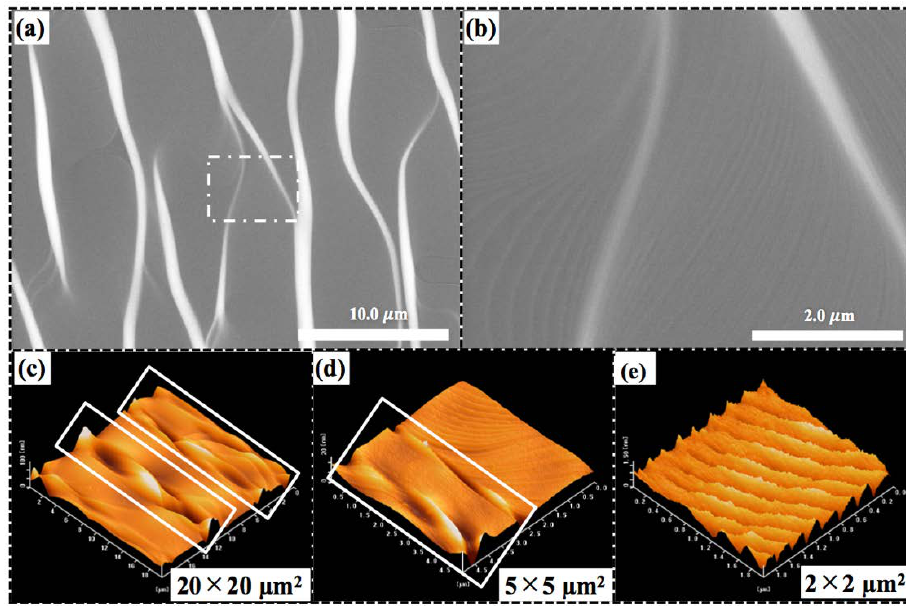
Figure 2. Planar scanning electron microscope (SEM) and atomic force microscope (AFM) images of the as-grown fluorescent substrate before anodic oxidation. Planar SEM images at ( a ) low-magnification and ( b ) high-magnification. ( c – e ) AFM images of the substrate at low, medium, and high magnification, respectively.